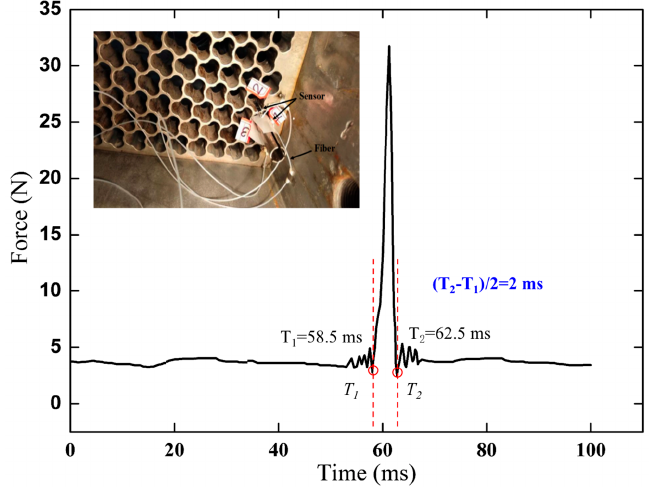
Figure 15. Demodulated force data coming from sensor #1 installed in the SGT, the inset image is the experimental photo when three force sensors installed in a 1:1 steam generator test loop.